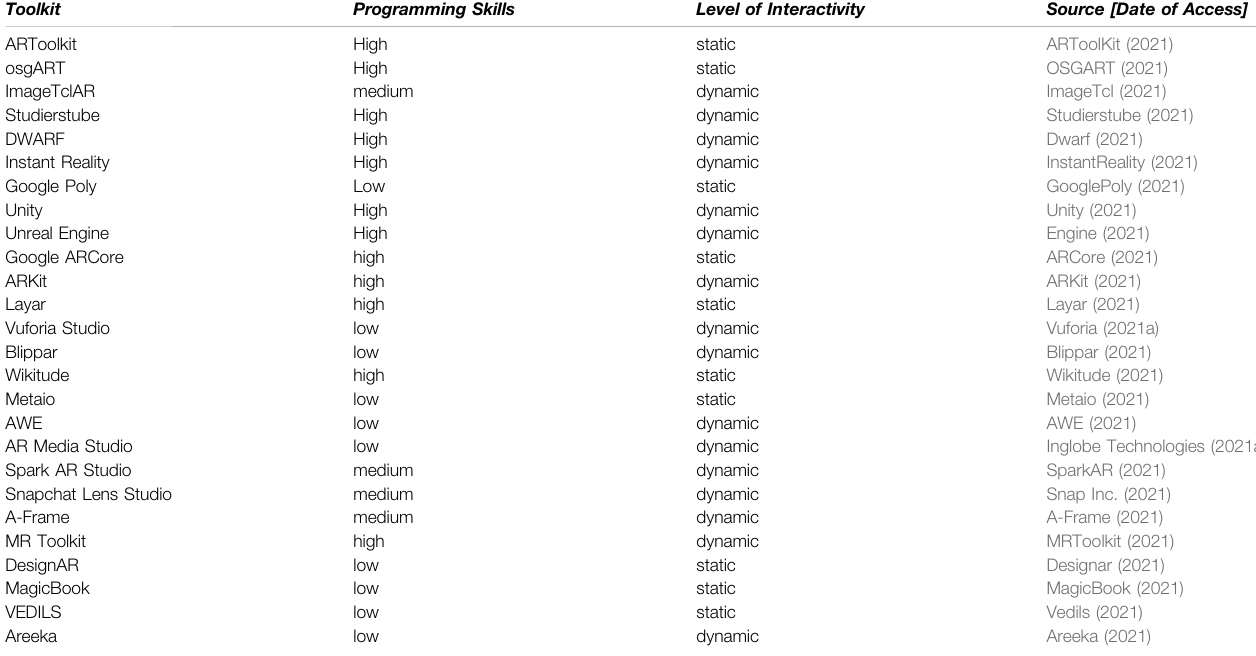
TABLE 2 | Accessible AR authoring toolkits and their characteristics. Toolkit